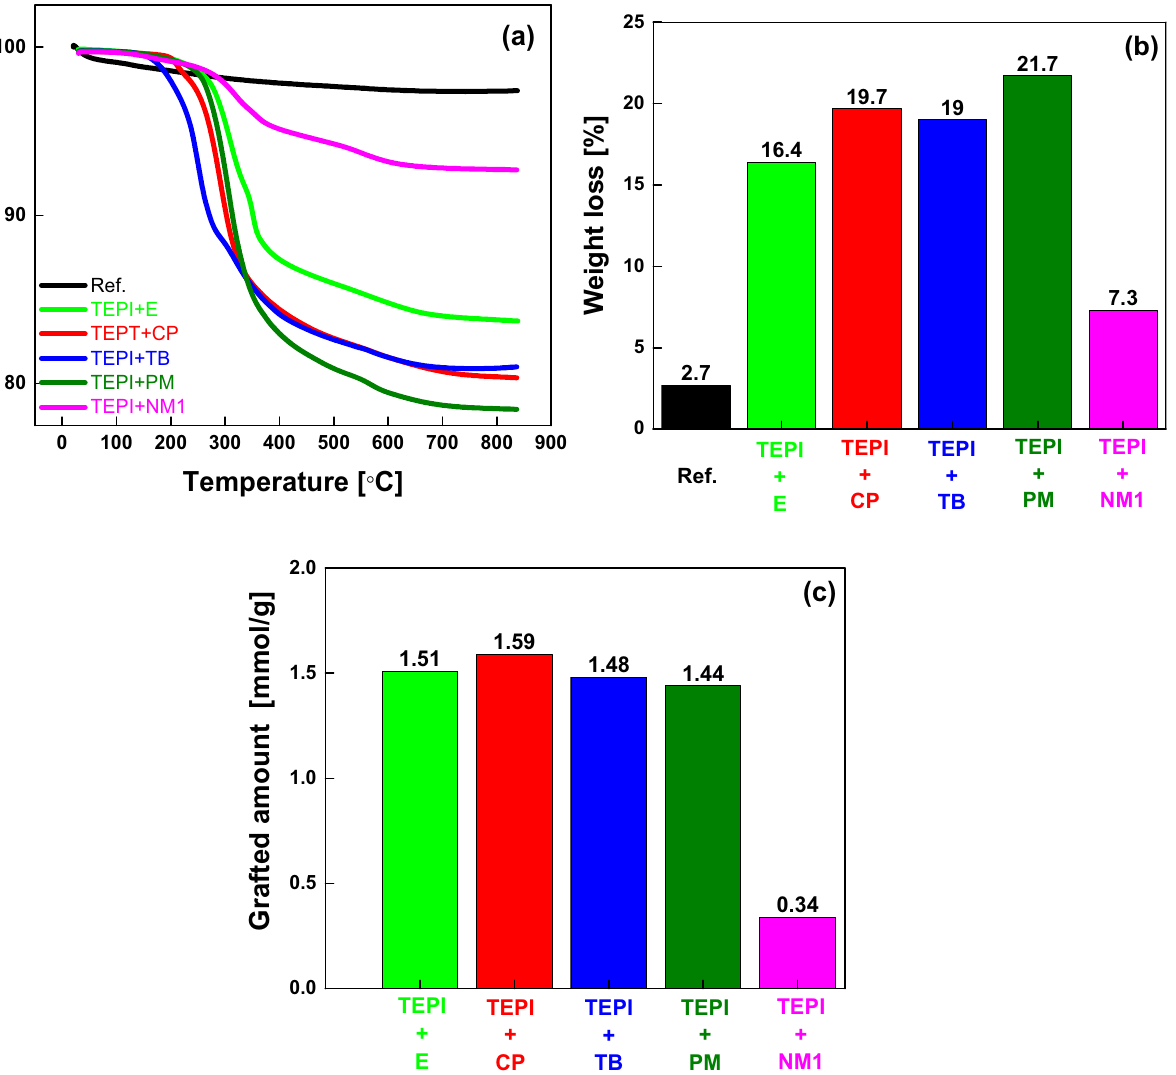
Figure 8: TGA curves of the reference silica and modi fi ed silicas ( a ) , weight loss up to a temperature of 850°C ( b ) , and molar grafting e ff ectiveness of the silanes ( c )